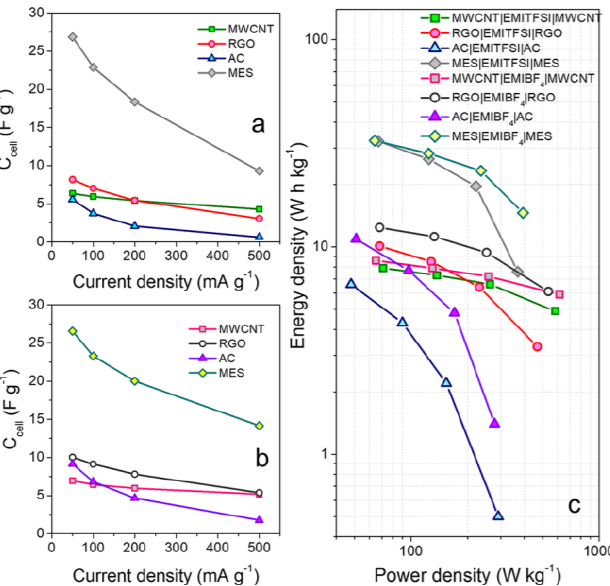
Figure 7. Specific cell capacitance for the EDLCs with different porous carbon electrodes and with ( a ) EMITFSI and ( b ) EMIBF 4 as electrolytes; ( c ) Ragone plot for all evaluated EDLCs. Reprinted 2020 ( a ) EMITFSI and ( b ) EMIBF (cid:2872) as electrolytes; ( c ) Ragone plot for all evaluated EDLCs. Reprinted from [131] with permission from the American Chemical 2020 from [131] with permission from the American Chemical Society.